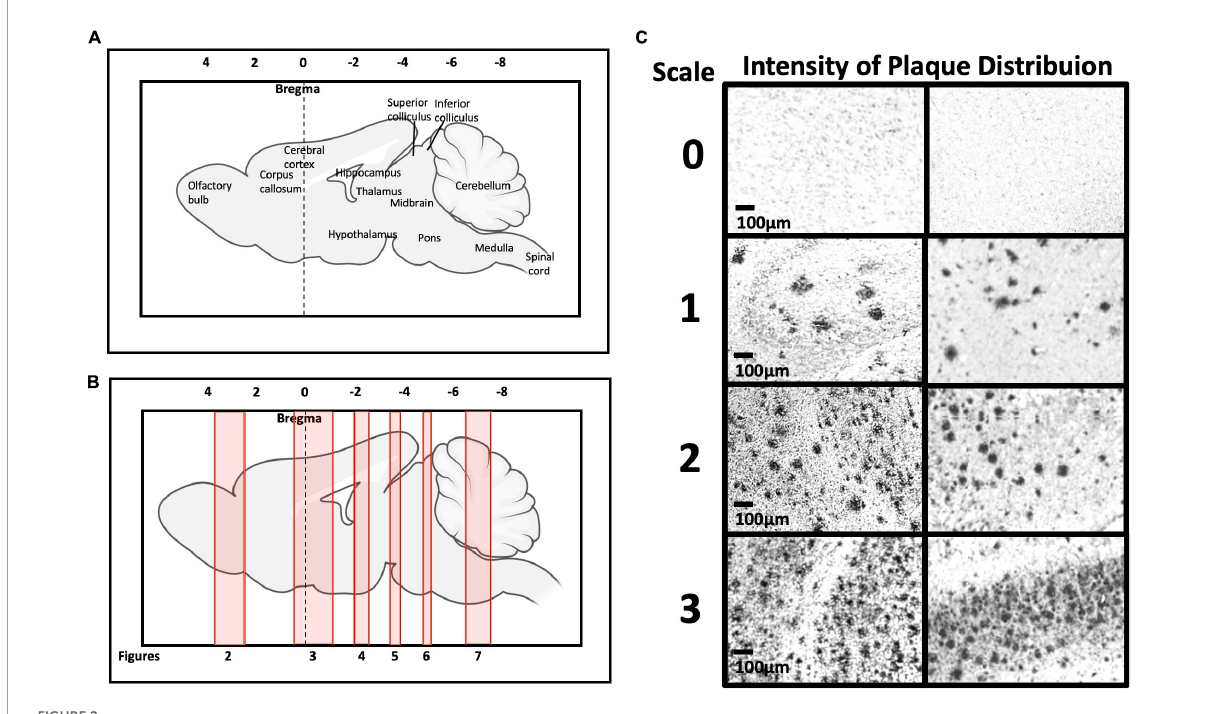
FIGURE2 (A,B) Representation of brain rostro-caudal levels of A β deposition within the respective coronal brain sections depicted in Figures 2 – 8 . (C) Categorization of A β deposition according to the intensity level (0 = no deposition; 1 = mild; 2 = moderate; 3 = high).